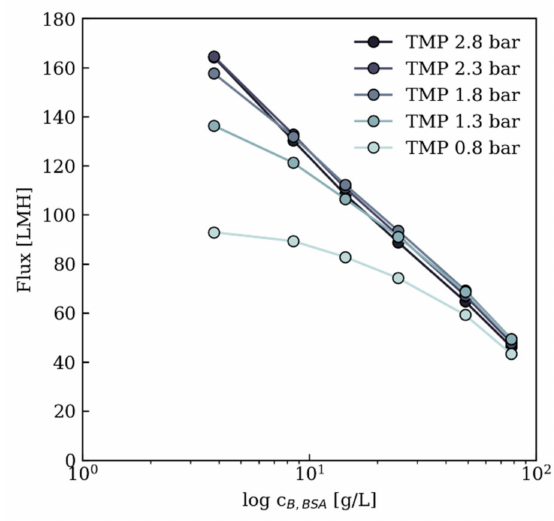
Figure A6. Permeate flux vs. logarithmic c B,BSA to estimate the mass transfer coe ffi cient k and gel concentration c G for the stagnant film theory (SFM). Data recorded at CF 200 mL /